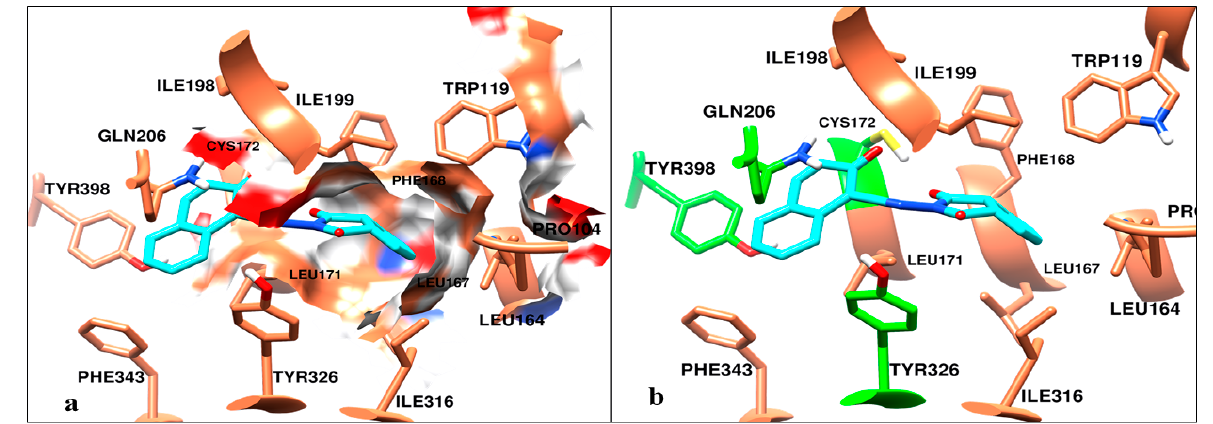
Figure 10. Image ( a ) shows the residues that form a hydrophobic pocket in MaO-B and are critical for the interaction with the ligands. ( b ) shows the residues (green) involved in hydrogen bonding and pi-cation interactions.